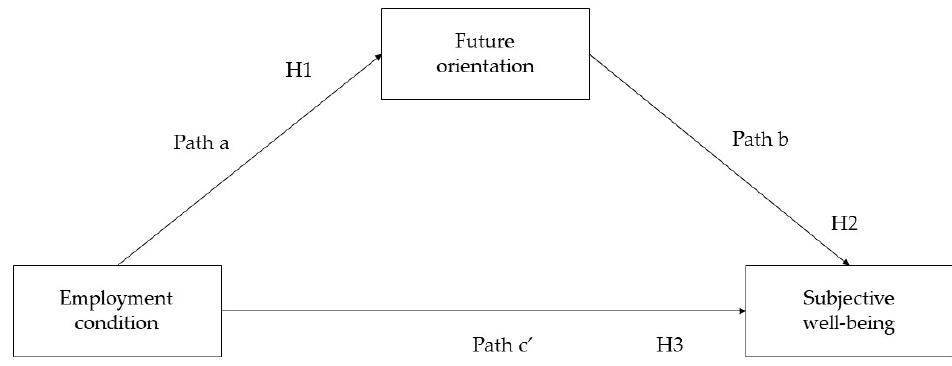
Figure 1. Statistical Diagram.